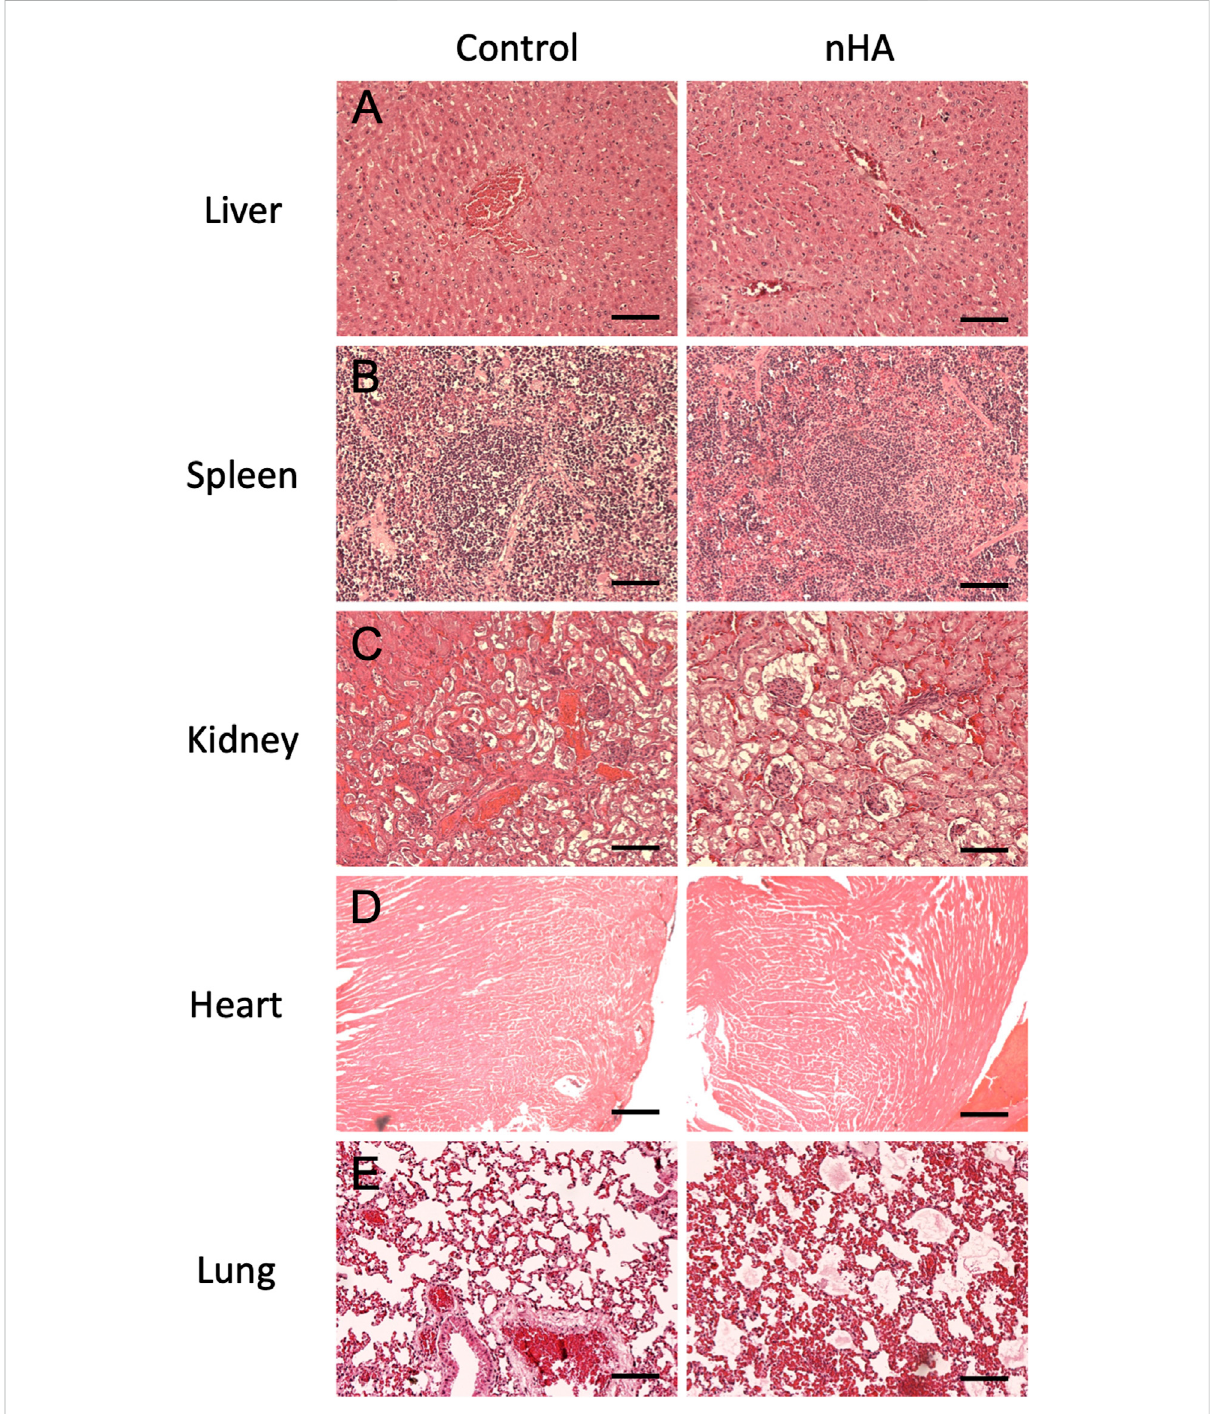
FIGURE 6 H and E staining of vital organs after HA particle implantation performed to detect the histopathological changes after local HA implantation. (A – E) Showsthemicrostructureofliver,spleen,kidney,heartandlungbetweencontrolandnHAgroup.Nodifferencescouldbeobservedinthetwo groups indicating that the local HA implantation did not cause histopathological changes in the vital organs in our model. Scale bar = 100